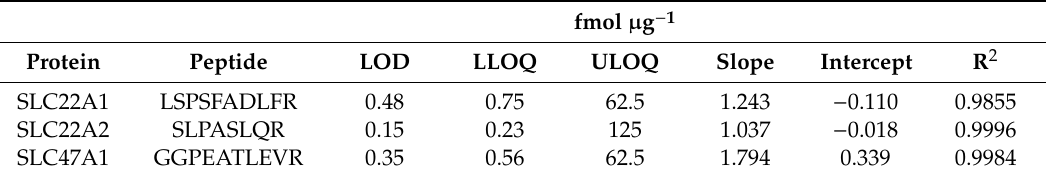
Table 2. Calibration curve parameters. Definitions: Limit of detection (LOD), lower limit of quantification (LLOQ), upper limit of quantification (ULOQ). fmol µ g − 1 Protein Peptide LOD LLOQ ULOQ Slope Intercept R 2 SLC22A1 LSPSFADLFR 0.48 0.75